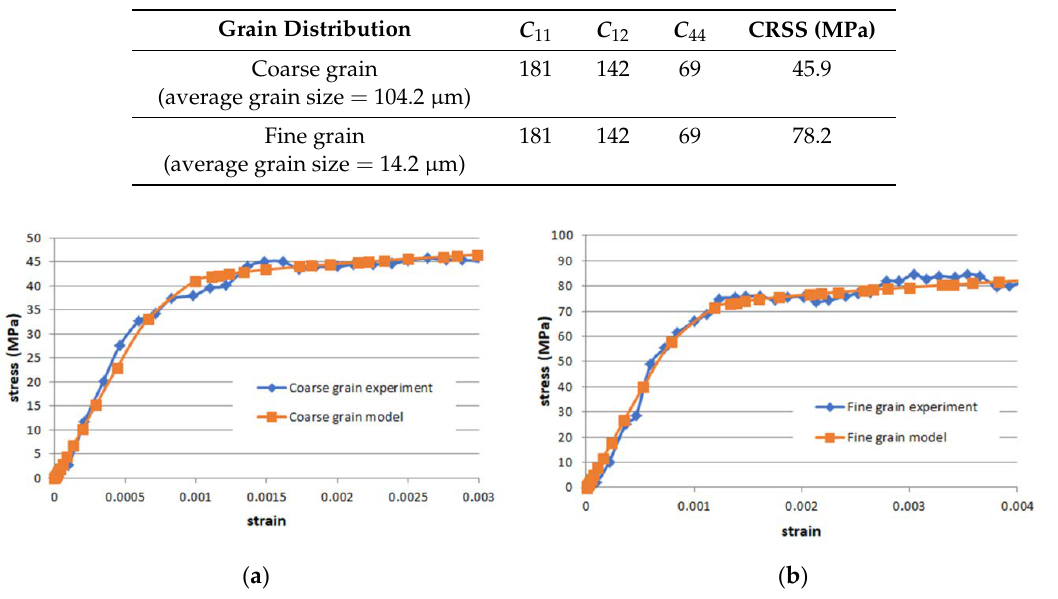
Figure 6. Comparison of the predicted stress–strain response with experimental uniaxial tension testing for ( a ) coarse grain and ( b ) fine grain.